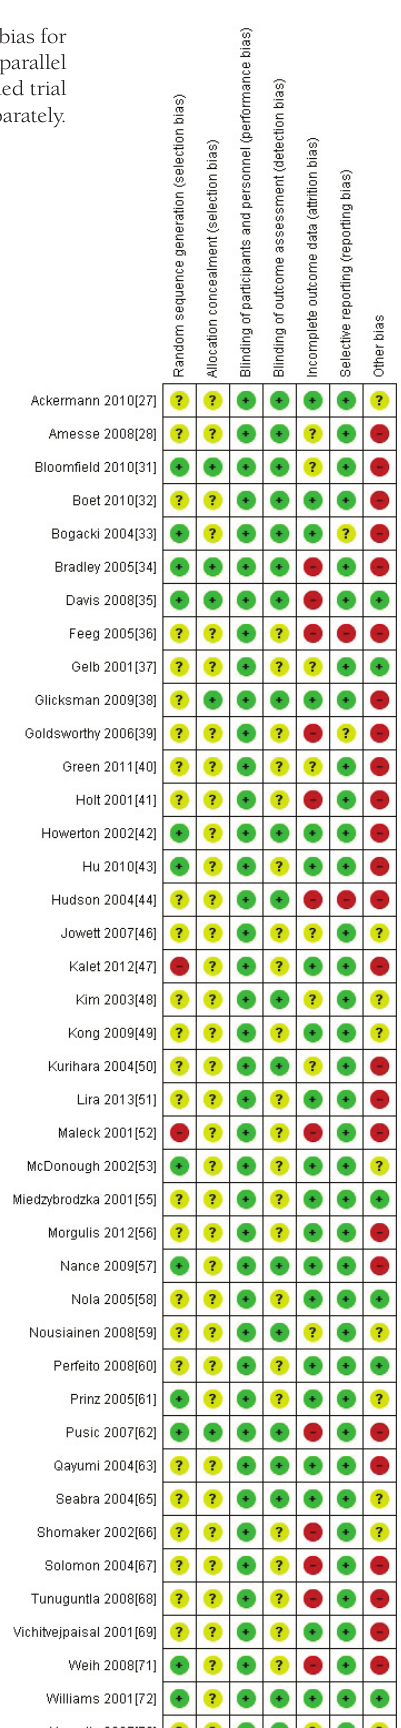
Figure 3. Overall risk of bias graph.